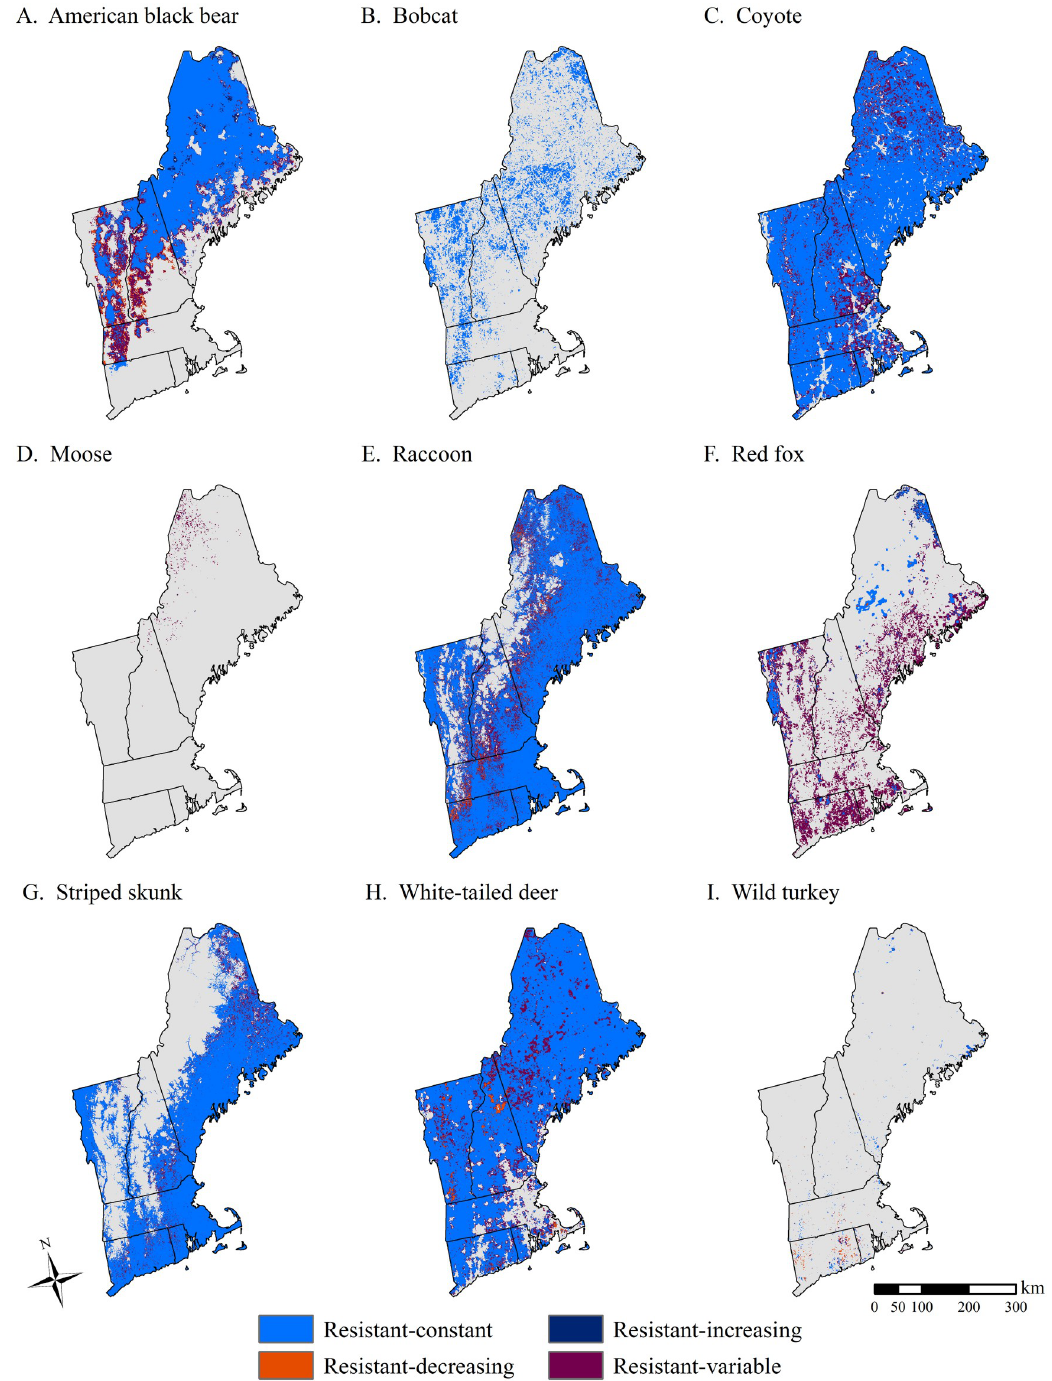
Fig 3. Estimated resistance for nine wildlife species in New England, USA. Resistance was based on scenario projected distribution change between 2010 and 2060. Resistant cells represent areas with high occurrence probabilities ( > 0.7) under current conditions and across all NELFP scenarios. Resistance is displayed by resistance class: 1) Resistant-constant: occurrence probability remained high ( > 0.7) and relatively constant across all scenarios, 2) Resistant-increasing: occurrence probabilities remained high ( > 0.7) and increased under all scenarios, 3) Resistant-variable: occurrence probability remained high ( > 0.7) but fluctuated among the scenarios, and 4) Resistant-decreasing: occurrence probability remained high ( > 0.7) but decreased under all scenarios. Maps correspond with the following species: A) American black bear, B) Bobcat, C) Coyote, D) Moose, E) Raccoon, F) Red fox, G) Striped skunk, H) White-tailed deer, and I) Wild turkey. Map boundary data source: U.S. Census Bureau [29].